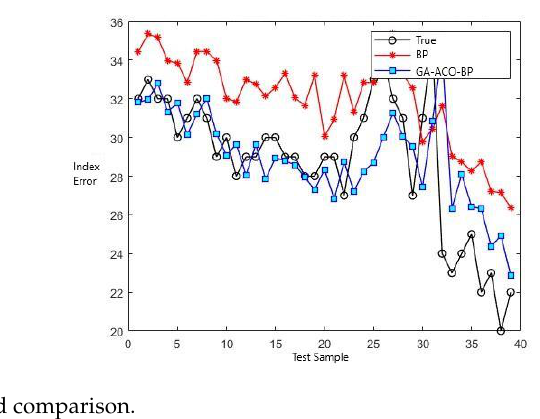
Figure 8. Speed prediction error and comparison.